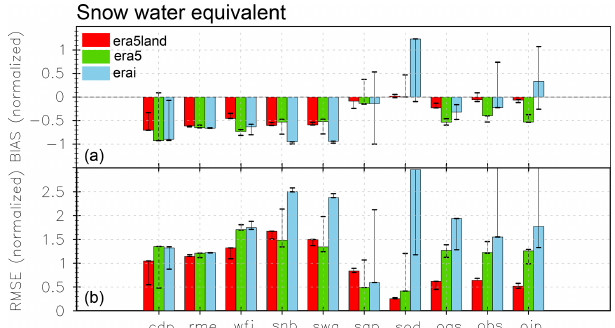
Figure 8. Summary statistics of the normalized mean bias (a) and RMSE (b) of snow water equivalent (SWE) at each ESM-SnowMIP site for ERA5-Land (red), ERA5 (green), and ERA-Interim (cyan). ESM-SnowMIP sites are described in Table 3. Each reanalysis box has a vertical line representing the variability at the four nearest grid points to the site